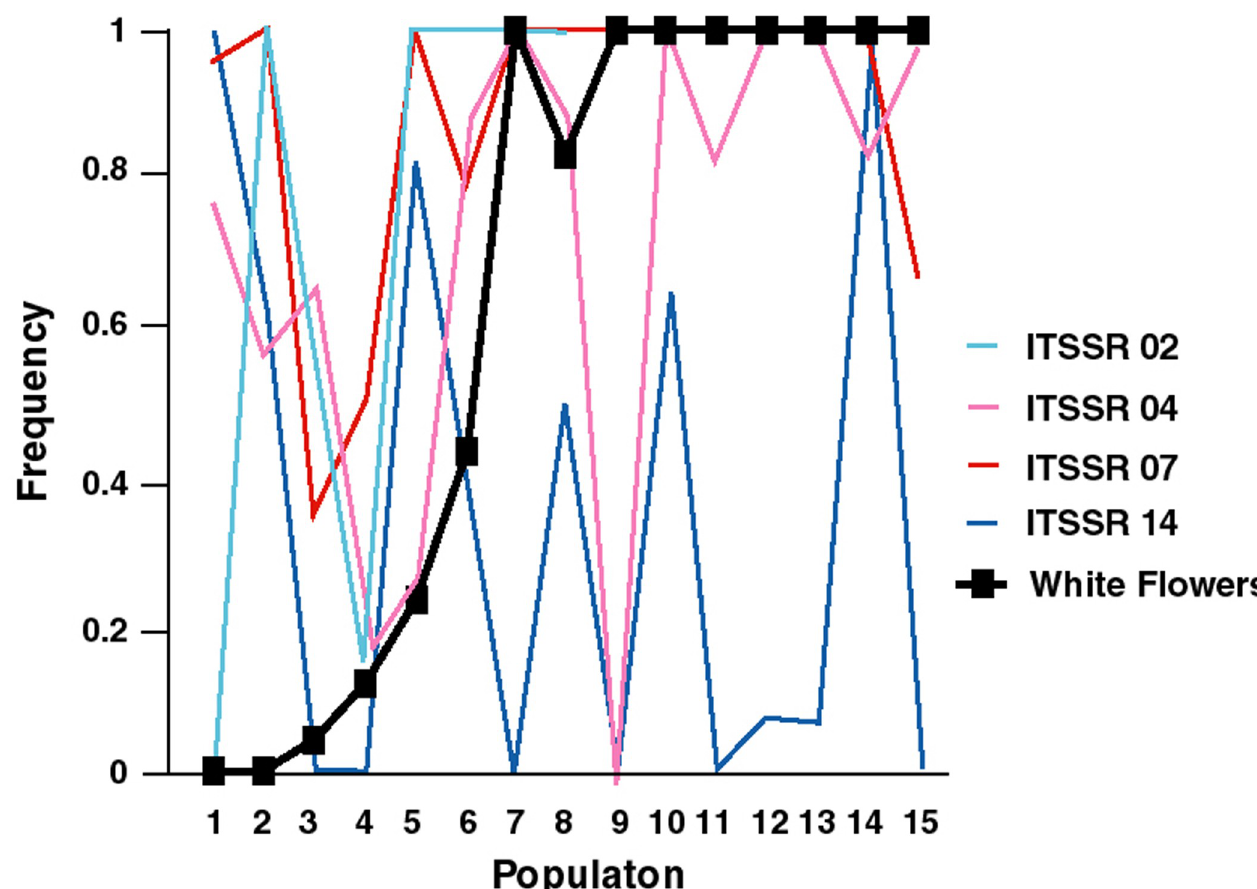
Fig 4. Variation in microsatellite allele frequencies and frequency of white flower across 15 populations with microsatellite data. Populations 1-7 contain Ipomoea cordatotriloba and 8–15 contain I . lacunosa